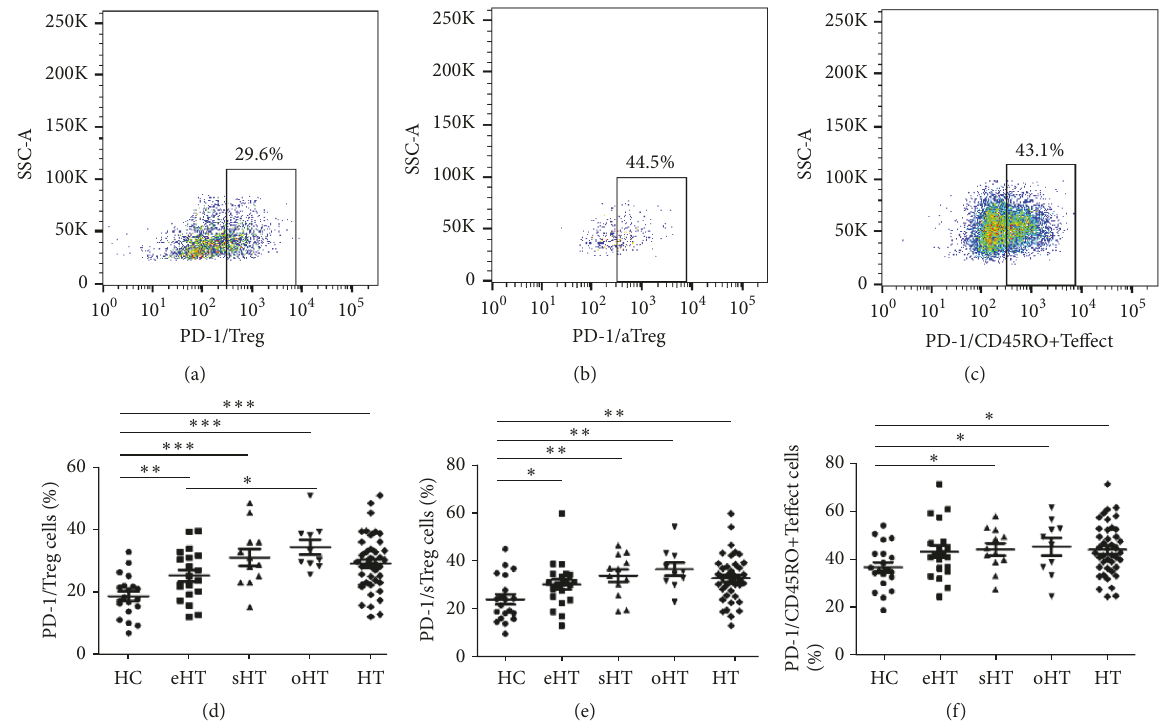
Figure 4: PD-1 expression on Treg and Teffect cells. Representative flow cytometric plots of PD-1 staining in (a) Treg, (b) aTreg, and (c) CD45RO + Teffect cell from one HT patient. Difference of the percentage of PD-1 within (d) Treg cells, (e) sTreg cells, and (f) CD45RO + Teffect cells among different groups ( ∗ P < 0.05; ∗∗ P < 0.0075; ∗ ∗ ∗ P <